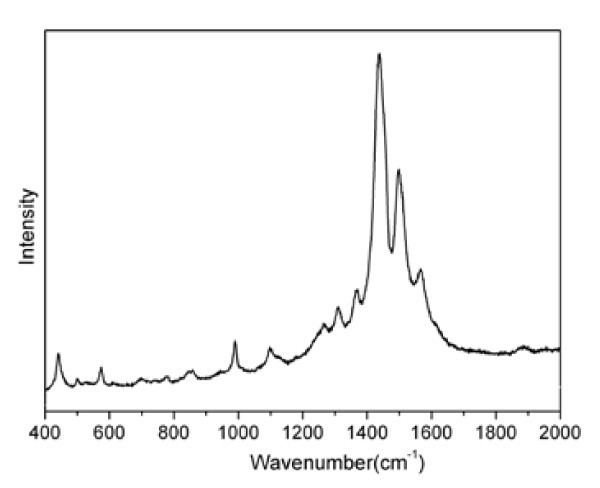
Raman spectrum of PEDOT-NO3 film.